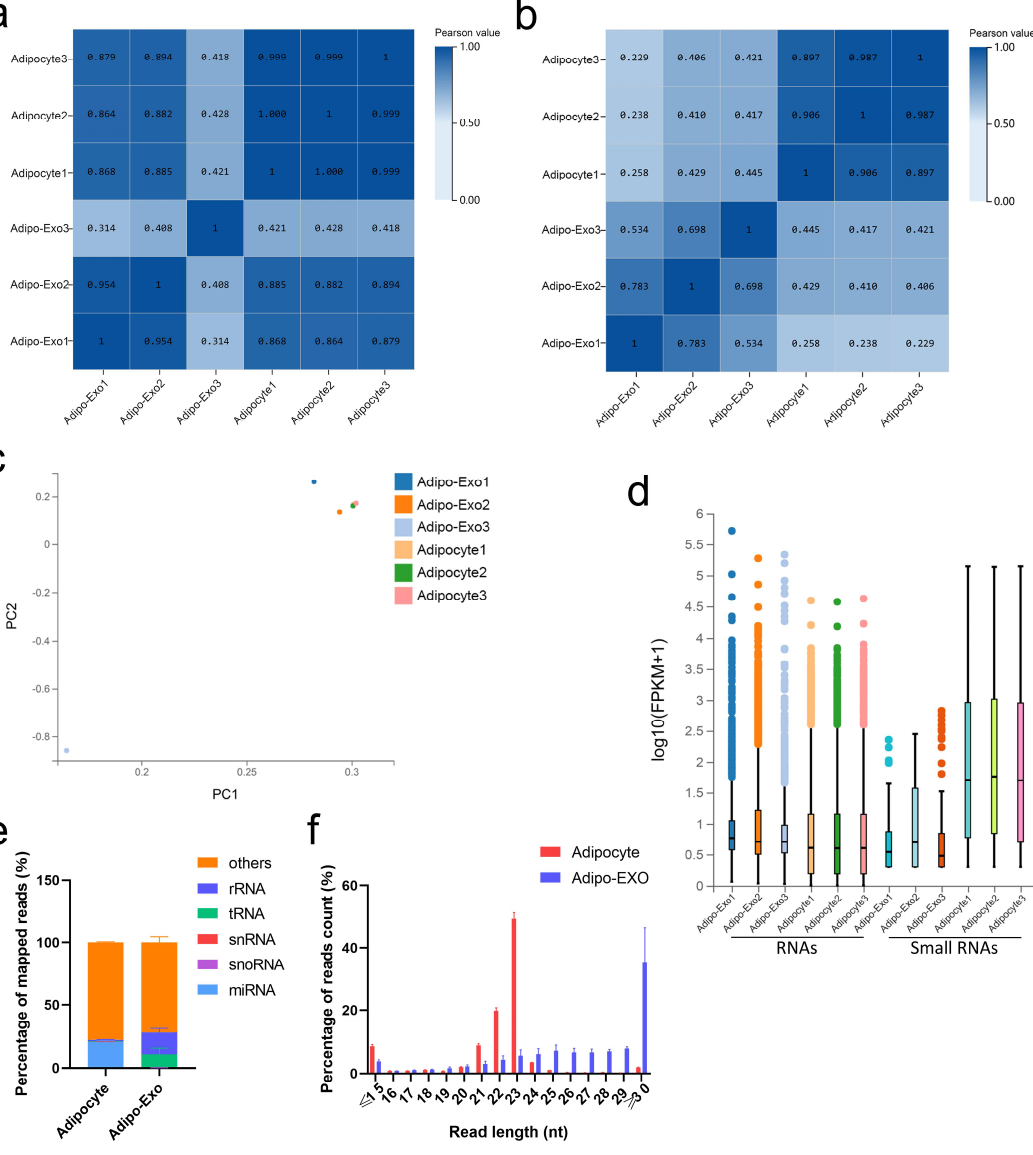
Figure 2. Analysis of the sequencing data. ( a , b ) Heat maps showing Pearson correlations of RNA ( a ) and small RNA ( b ) from adipocyte-derived exosomes and adipocytes. ( c ) Principal component analysis (PCA) of all normalized RNA sequencing data. ( d ) Box plot of detected RNAs. ( e ) Percentage of di ff erent classes of small RNAs. ( f ) Length and frequency distributions of total small RNAs. Error bars indicate the